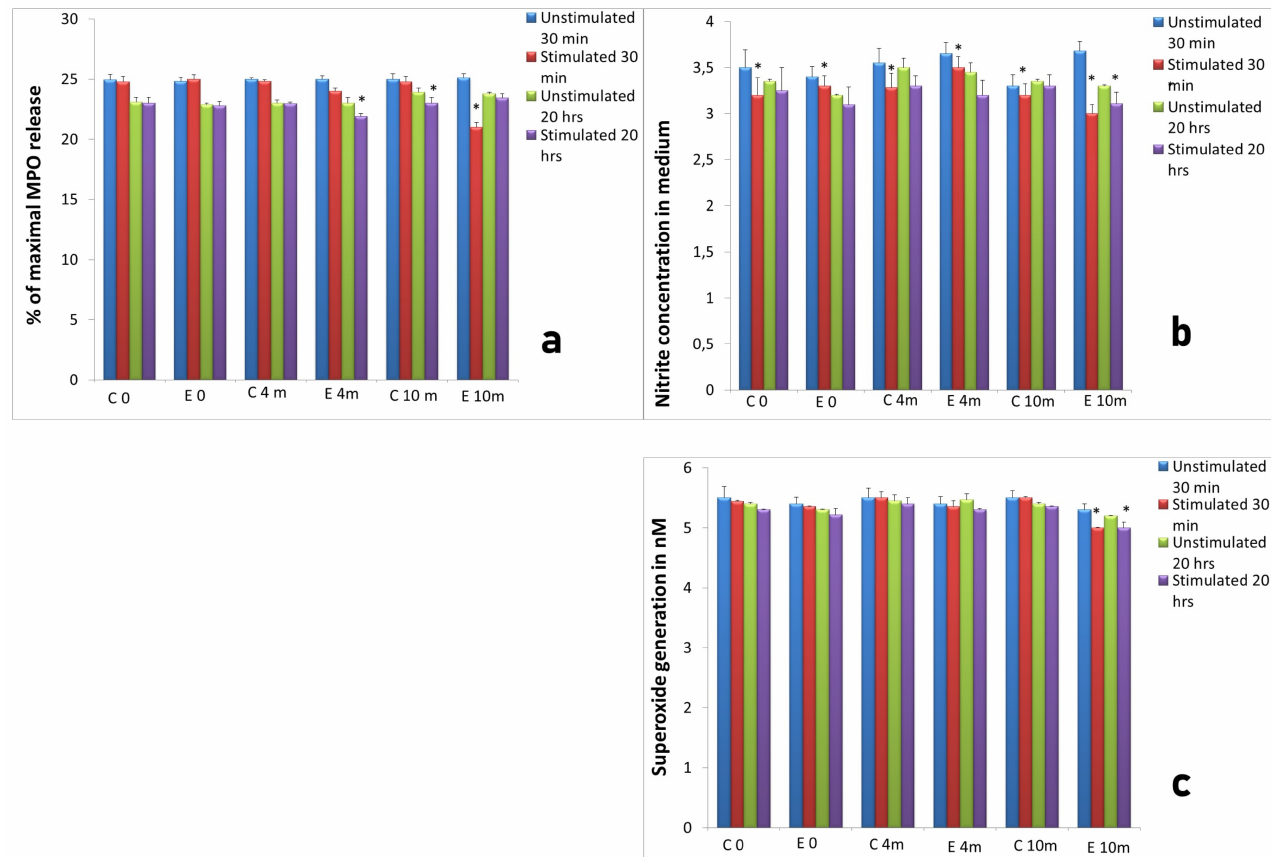
Figure 6. Activity of neutrophils isolated 4 and 10 months after implantation (experimental: 8 sheep) compared to control groups of neutrophils isolated at the same time points from animals from control groups (control: 4 sheep). The neutrophil response to Ti implant insertion, with or without stimulation with AMP extract; ( a ) MPO release from neutrophils, ( b ) NO generation, ( c ) superoxide generation assessed at two time points: 4 and 10 months after implantation. Two measurements, after 30 min and 20 h incubation at 37 ◦ C and 5% CO 2 were conducted. Data present mean values ± SE of at least three replicates for each bar. * p < 0.05 compared to cultures of neutrophils from the control group at the same time points. Legends: C0—control group before surgery, E0—experimental group before surgery, C 4m—control group 4 months after, E 4m—experimental group 4 months after, C 10m—control group 10 months after, E 10m—experimental group 10 months after insertion of a titanium